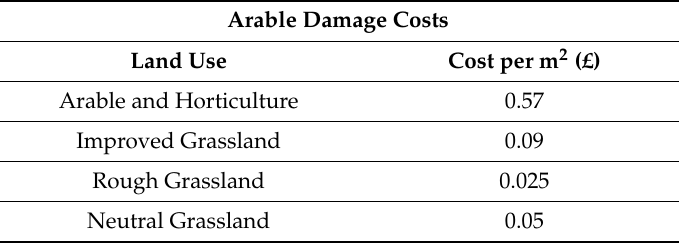
Table 2. Arable Damage Costs (£) per Inundated Cell [56].